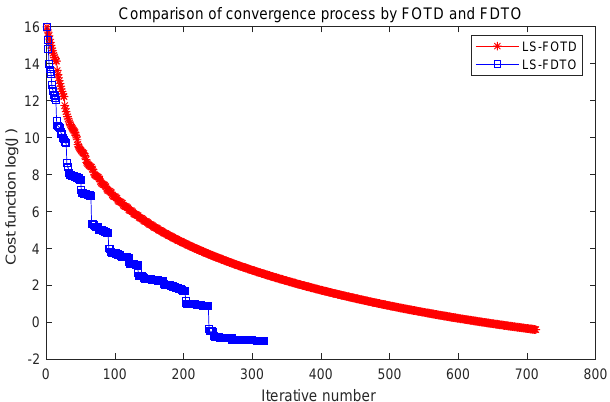
Figure 3. The total heat exchange factor in forms of the sine function.